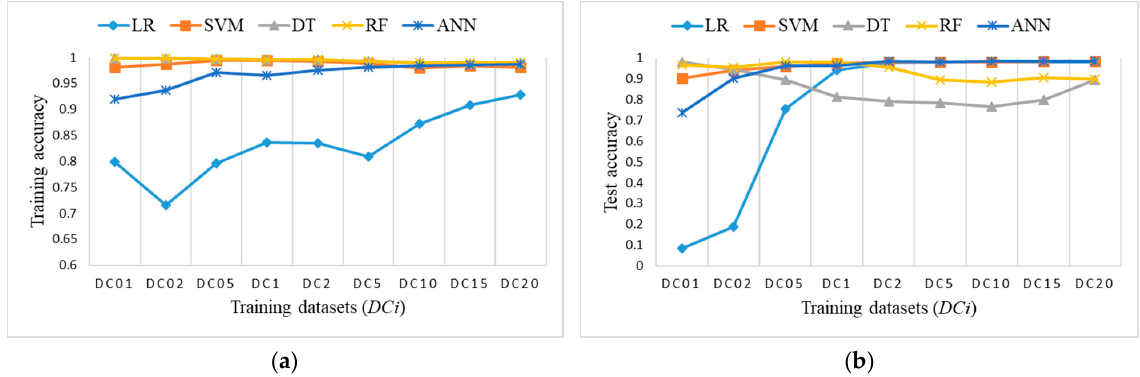
Figure 13. Accuracy measure for ML algorithms on balanced training datasets DCi : ( a ) training accuracy (coincidence of RF and DT); ( b ) test accuracy.